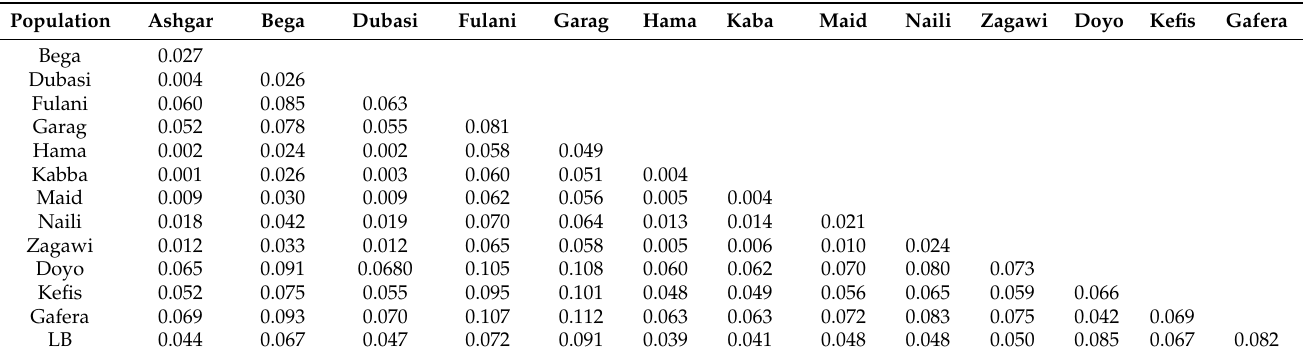
Table 2. Pairwise F ST (genetic differentiation) in the studied sheep